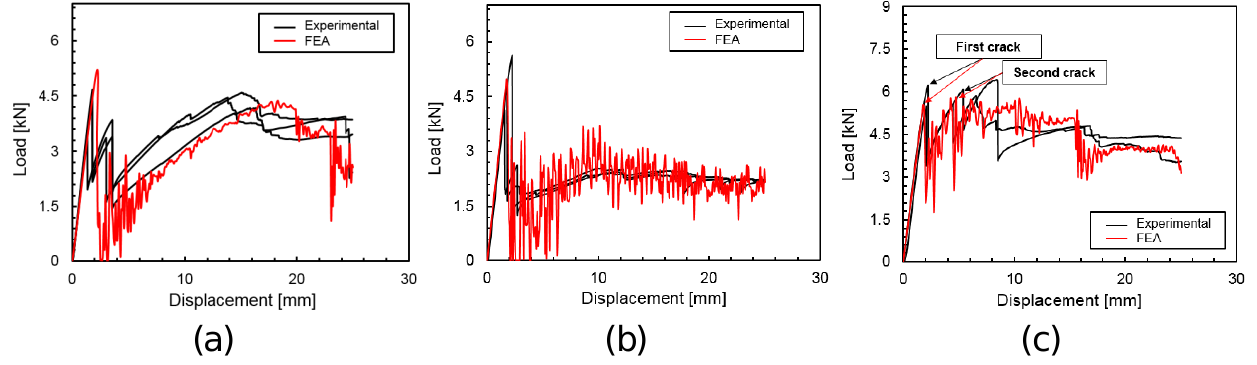
10 of 16 Figure 9. Comparison between the ε xz and ε zz strain contours of the three specimen configurations at an applied displacement of 1.2 mm. Configuration 3 showed the highest load plateau value, as a consequence of the po- sition of the two CFRP ribs stopping skin – core debonding from propagating; foam cracks and debonding were restricted to the central part of the sandwich beam. This is a key finding, as the positioning of the through-thickness reinforcements can be optimised in order to alter the shear stress distribution and produce delayed core failure. In addition, the ribs in ‘Configuration 3′ have restricted the debonding, foam damage, and failure in the core to a confined region, without decreasing the overall structural loading capability. 4.2. Comparison with FEA The FEA predictions for the load and displacement of all three configurations are compared with the experimental curves in Figure 10. The comparisons show good agree- ment between the experimental and numerical values, even at higher cross-head displace- ments . For ‘Configuration 1′ , the FEA model predicted foam failure at an applied load of 5.1 kN, compared to the experimental value of 4.2 ± 0.5 kN; for ‘Configuration 2′ , the pre- dicted value of 4.9 kN compares very well with the experimental 4.8 ± 0.7 kN; for ‘Config- uration 3′ , the first and second load drops, corresponding to the first core shear crack and the second crack, which were predicted at 5.5 kN and 5.4 kN, respectively, and were very similar to the experimental values of 5.9 ± 0.4 kN for the initial failure and 5.8 ± 0.3 kN for the second crack. Figure 11 shows the FE predictions of the location and extent of foam failure for all three configurations; the numerical model captured the foam failure well at the point of first peak load for all three configurations. In all cases, a crack initiated in the